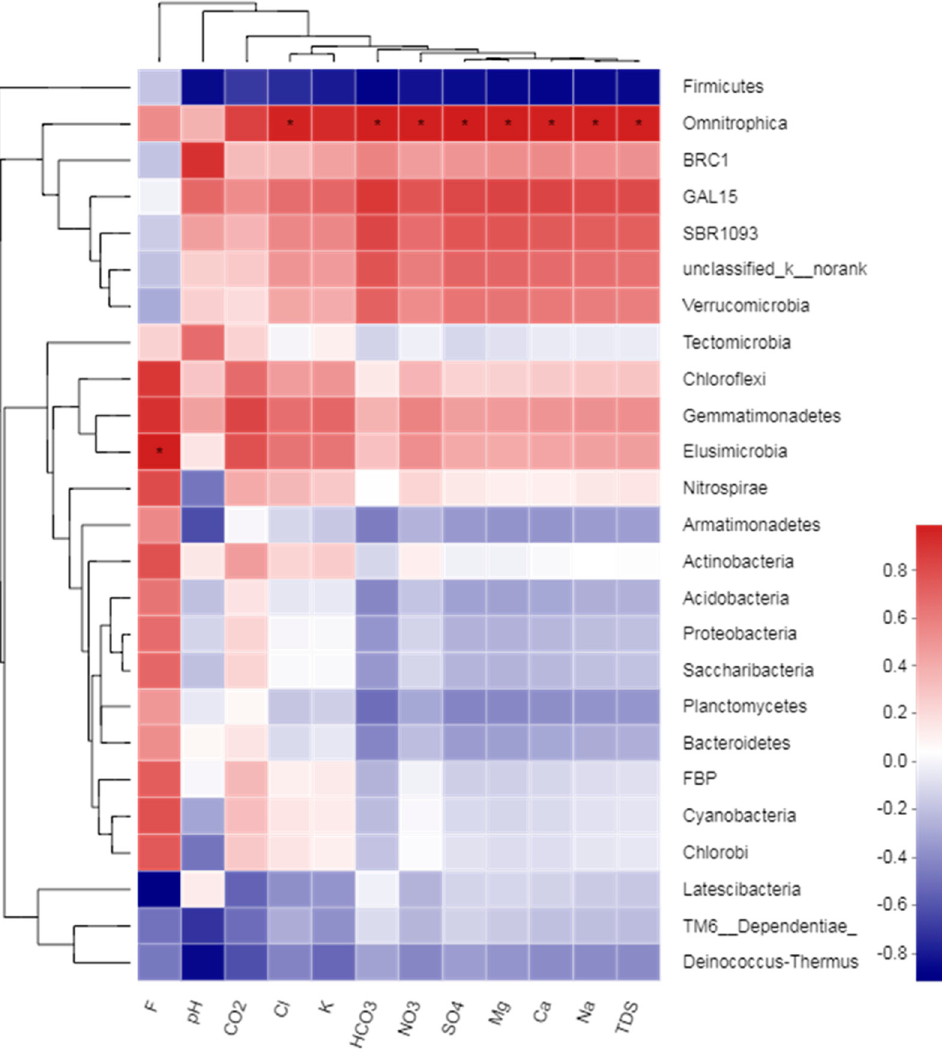
Figure 9. The correlation between microorganisms and environmental factors (* The correlation is significant at the 0.05 level; ** The correlation is significant at the 0.01 level).